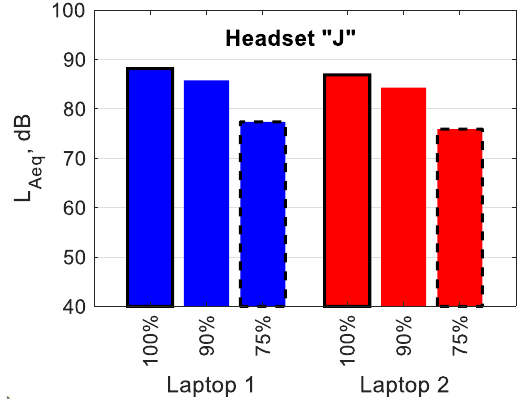
Figure 5. The values of A-weighted equivalent sound pressure level of the test signal reproduced by Headset J connected to Laptop 1 and Laptop 2 via Bluetooth. The values given as percentages indicate the control level values of the test signal.